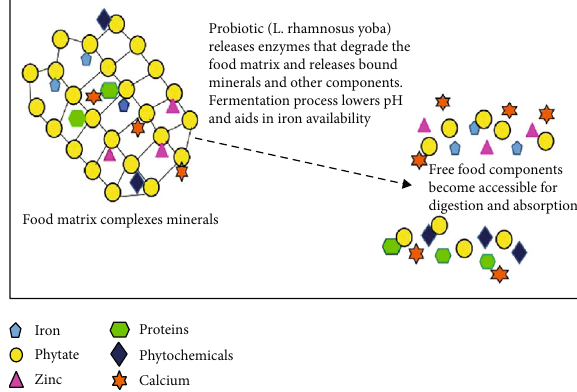
Figure 4: Possible L. rhamnosus yoba mechanism in increased mineral bioaccessibility (adopted from Sripriya et al. [35]). Table 5: Viability of L. rhamnosus yoba and pH in